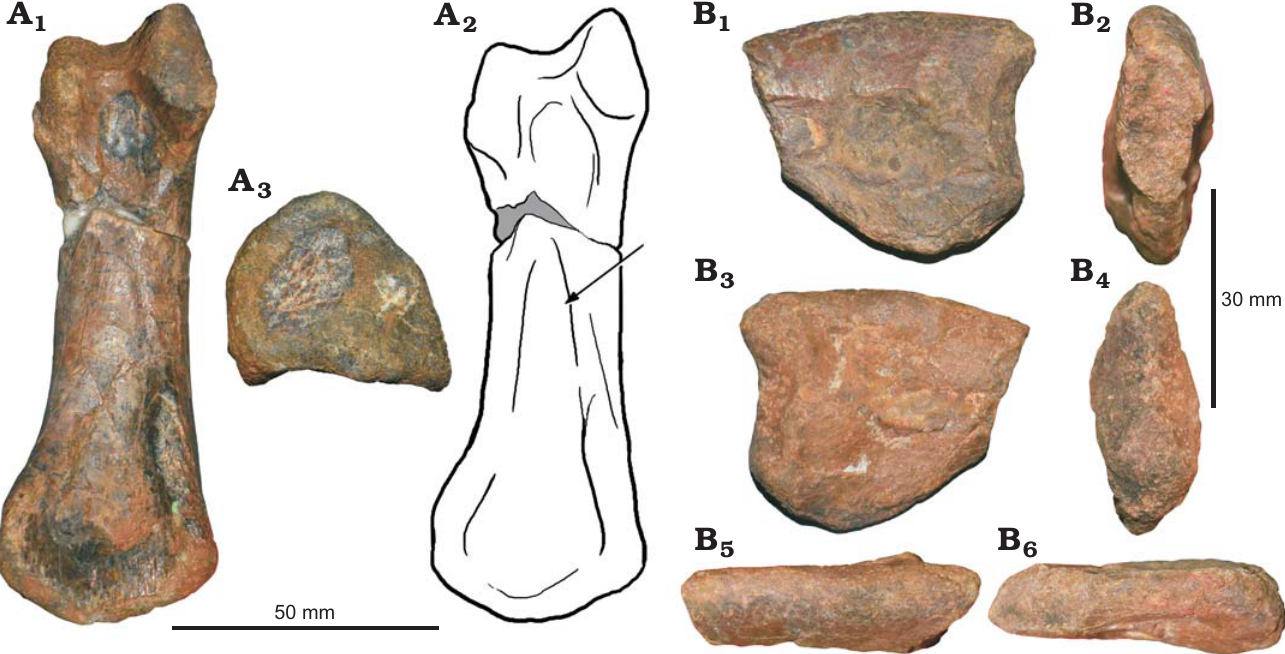
Fig. 7. Coelurosaurian theropod Phuwiangvenator yaemniyomi gen. et sp. nov. from the Early Cretaceous Sao Khua Formation of Phu Wiang, Khon Kaen Province, Thailand. A . SM-PW9B-3, manual phalanx I-1 in ventral (A 1 ) and proximal (A 3 ) views; line drawing in ventral view (A 2 ). B . SM-PW9B-19, manual ungual I-2 in medial (B 1 ), distal (B 2 ), lateral (B 3 ), proximal (B 4 ), dorsal (B 5 ), and ventral (B 6 ) views. Arrow indicates the longitudinal ventral